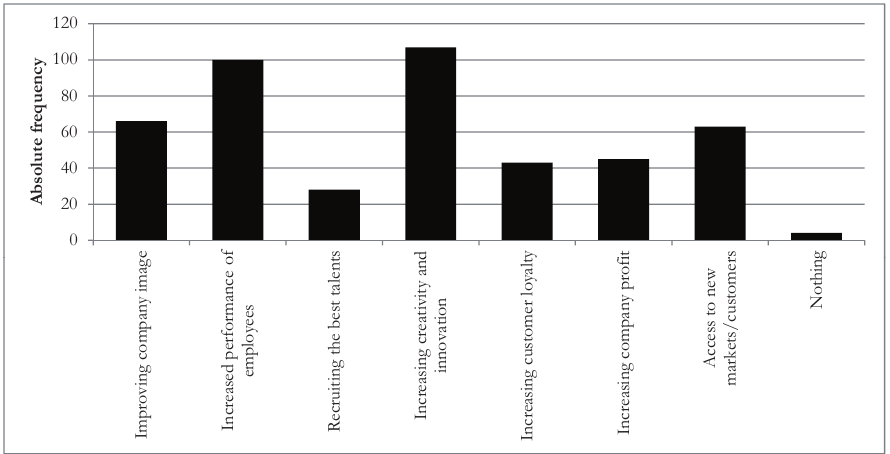
Fig. 7 - Benefits of diversity by respondents. Source: own processing, 2013.